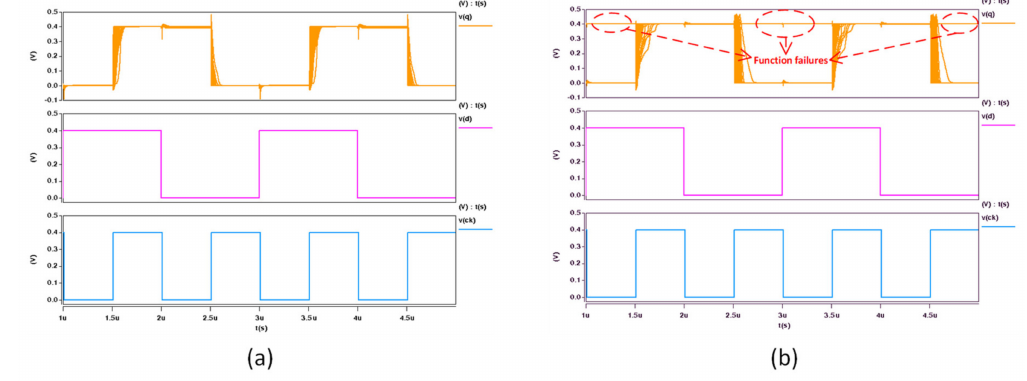
Figure 12. Monte Carlo simulation waveform at the voltage of 0.4 V. ( a ) The proposed design; ( b ) Conventional